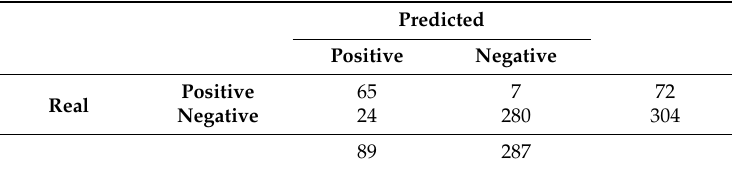
Table 6. Confusion matrix summarising the results from all patients.